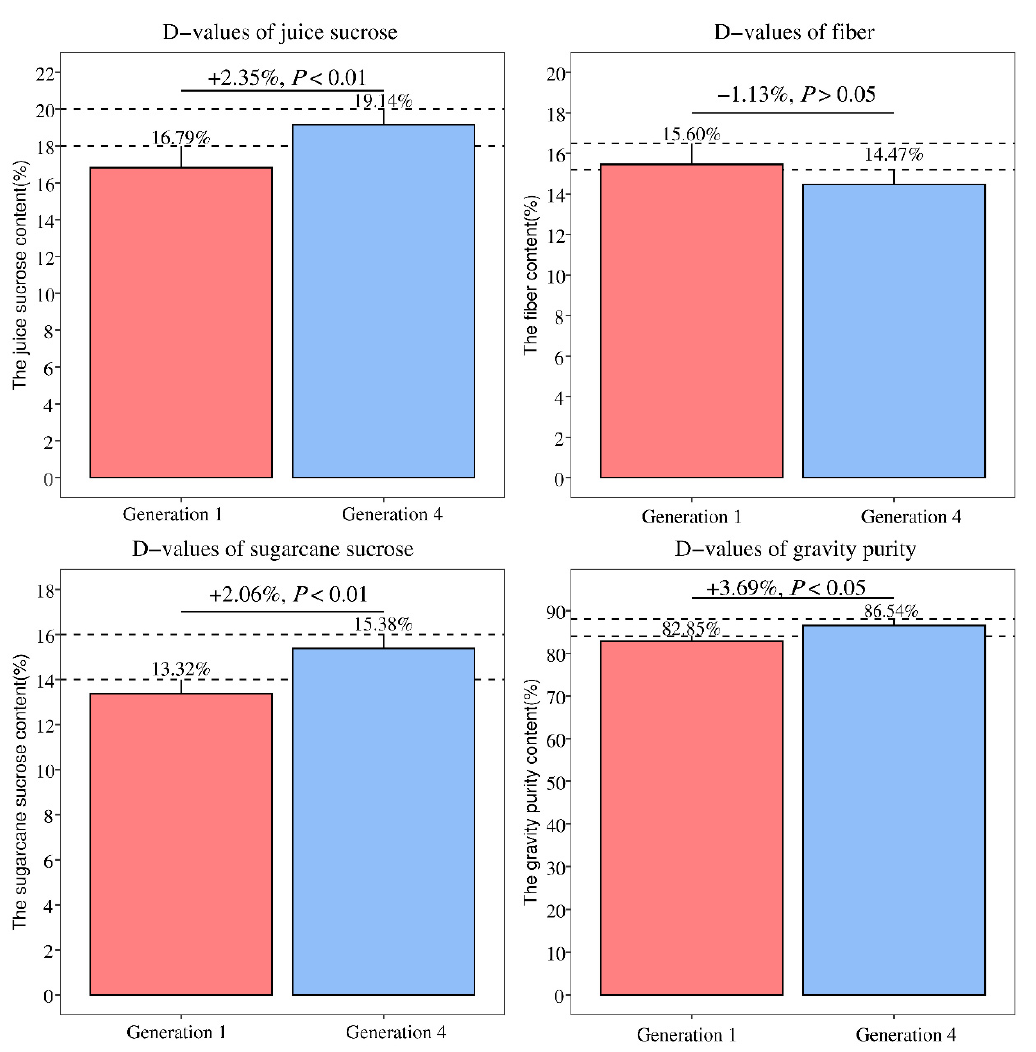
Figure 6. Differences (D-value) in the four technological traits (sucrose content of sugarcane, sugar content of the juice, purity, and fiber content) between Generation 4 and Generation 1 of sugarcane varieties in China, determined by the LSD test.